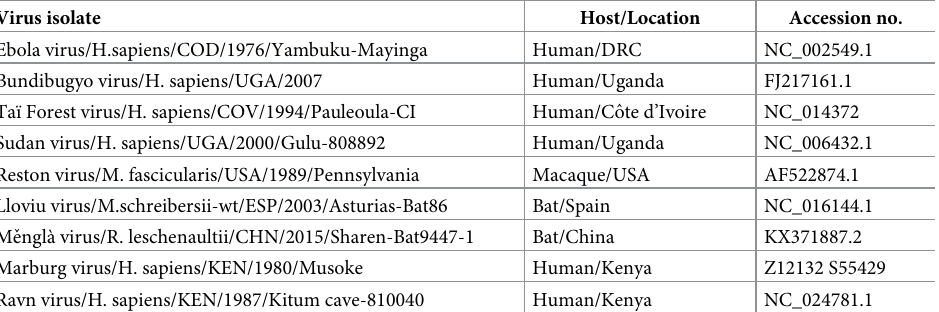
Table 1. Virus name, host and location of isolation, and accession numbers for recombinant filovirus attachment glycoproteins (GPe) used in multiplex serological binding assays. Virus